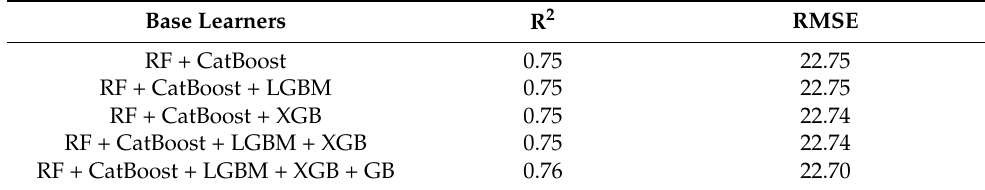
Table 5. Performance of the five stacked model for the different combinations of base learners.